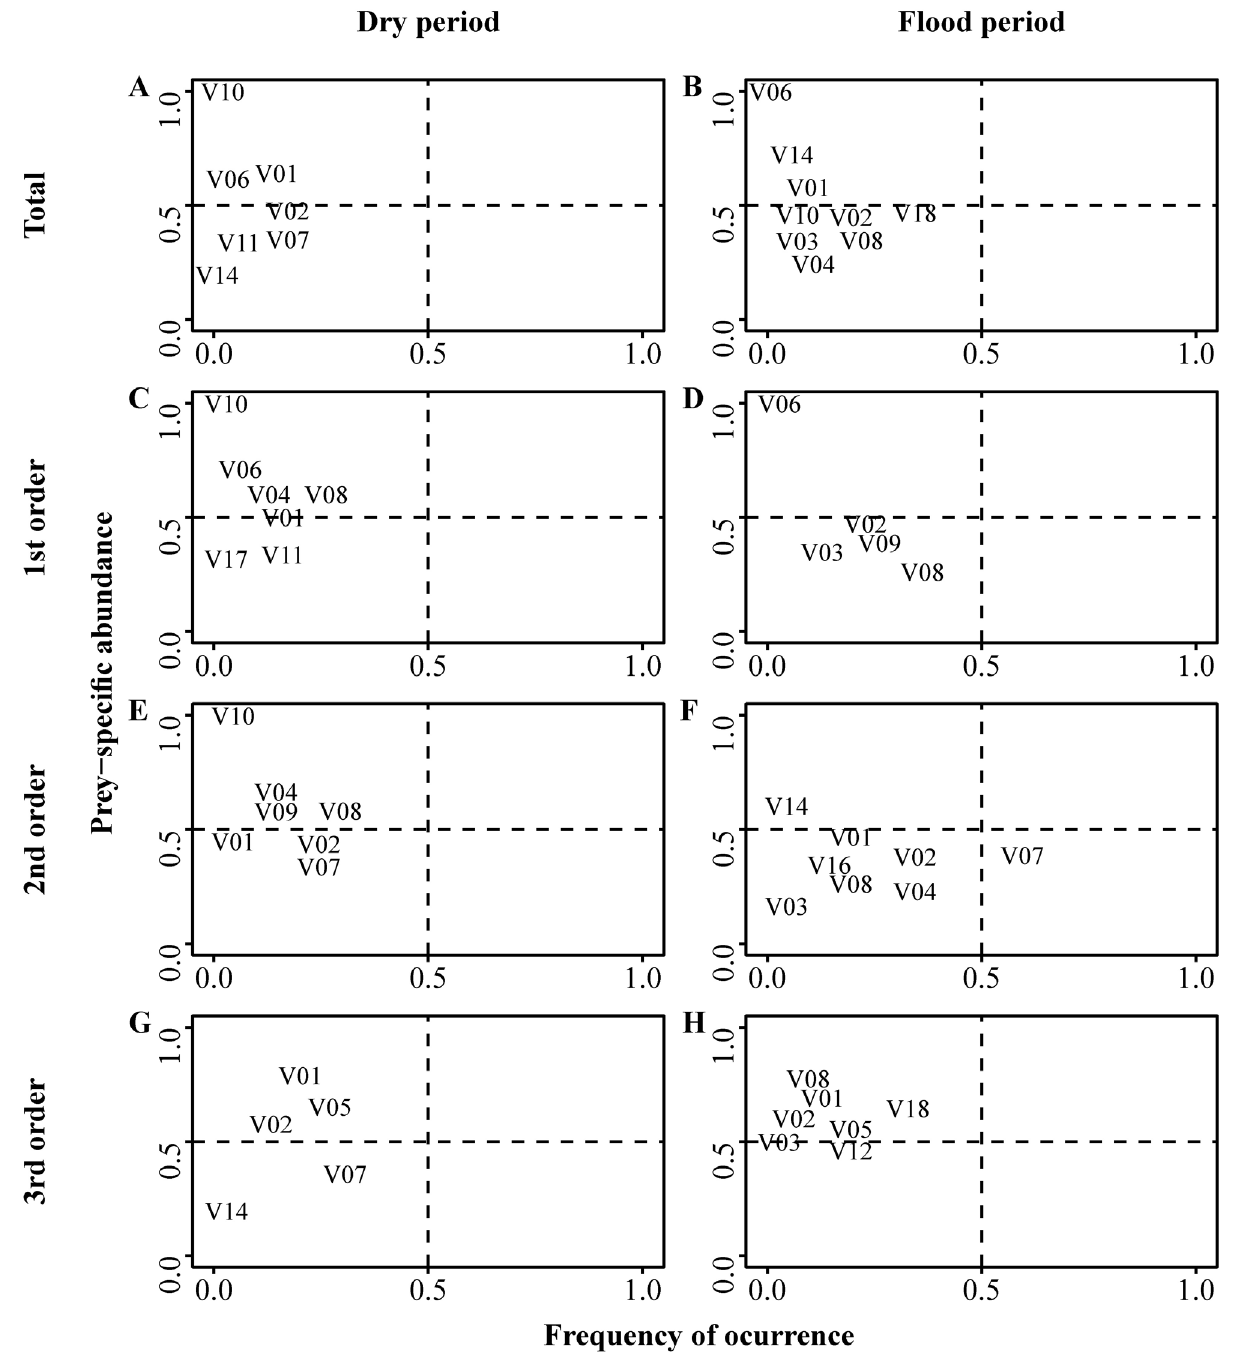
FIGURE 2 | Feeding strategy revealed by Amundsen diagram of Hyphessobrycon heterorhabdus sampled in eight streams of a protected area in the Eastern Amazon, Brazil. A , C , E , and G represent feeding during the dry period, while B , D , F , and H represent the flood period. A and B show the diet considering all streams, whilst C and D represent 1 st order streams, E and F represent 2 nd order streams, and G and H represent 3 rd order streams. V01 = Ephemeroptera (nymph); V02 = Odonata (larvae); V03 = Coleoptera (larvae); V04 = Diptera (larvae); V05 = Diptera (eggs); V06 = Diptera (pupae); V07 = Exoskeleton fragments (autochthonous source); V08 = Exoskeleton fragments (unknown source); V09 = Exoskeleton fragments (allochthonous source); V10 = Isoptera; V11 = Formicidae; V12 = Trichoptera; V13 = Hemiptera; V14 = Ephemeroptera; V15 = Orthoptera; V16 = Coleoptera; V17 = Heteroptera; V18 = Vegetal fragments (allochthonous